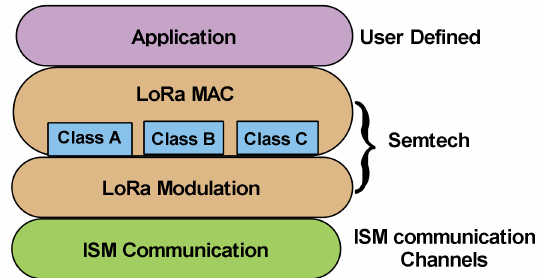
Figure 3. LoRaWAN node system architecture